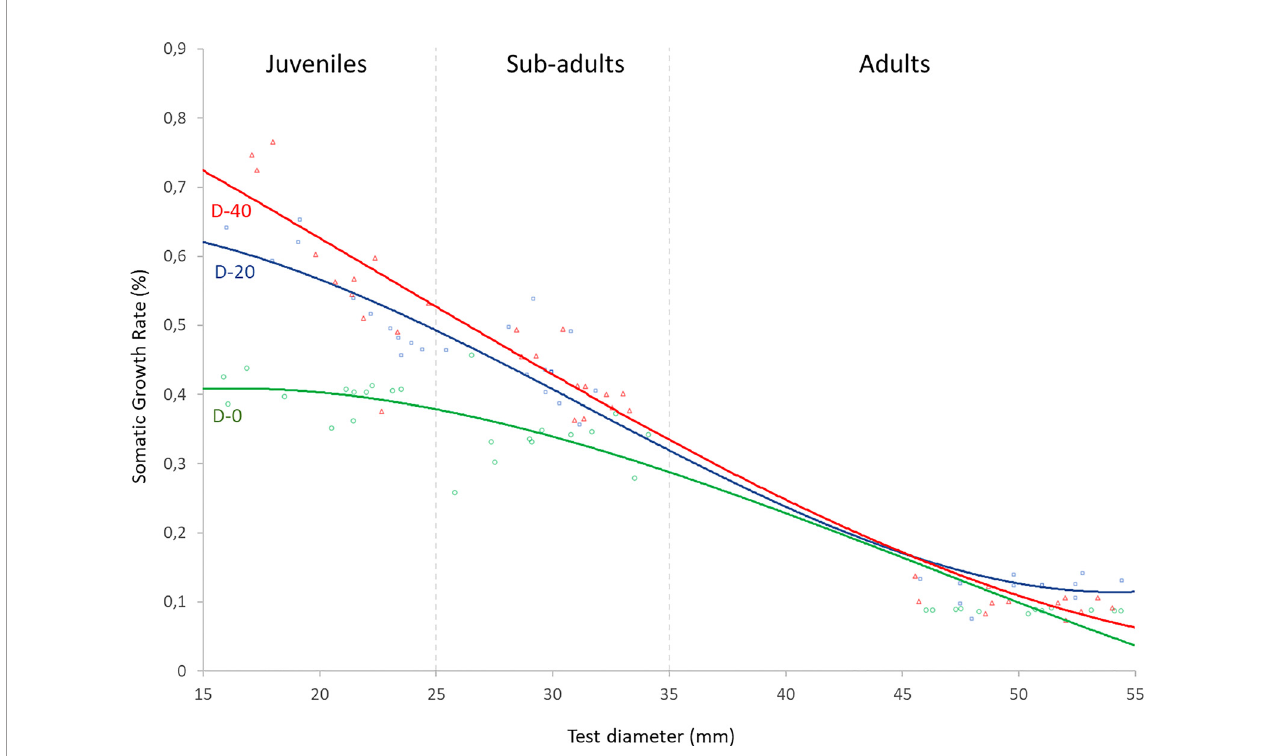
FIGURE 3 | LOESS curves describe the relationship between weight gain and diameter of P. lividus fed with three experimental diets. Y axis: Somatic Growth Rate of sea urchins during the four months of the experiment; X axis: diameter of sea urchins at the beginning of the